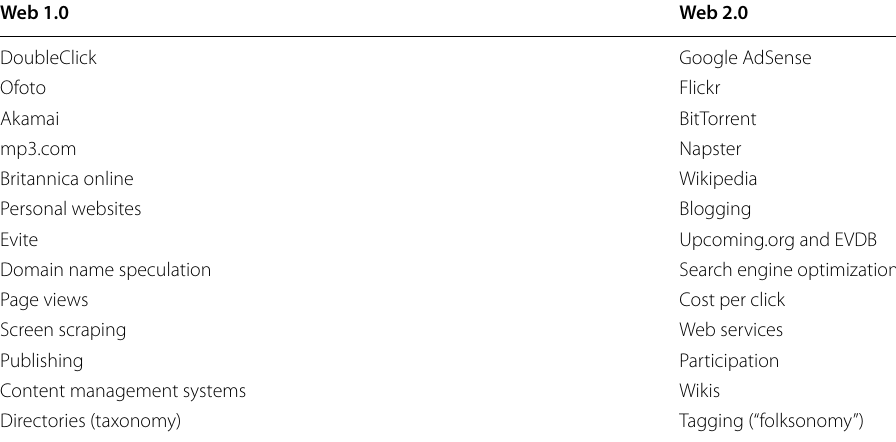
Table 3 Differences between Web 1.0 and Web 2.0. Source: O’Reilly [22] Web